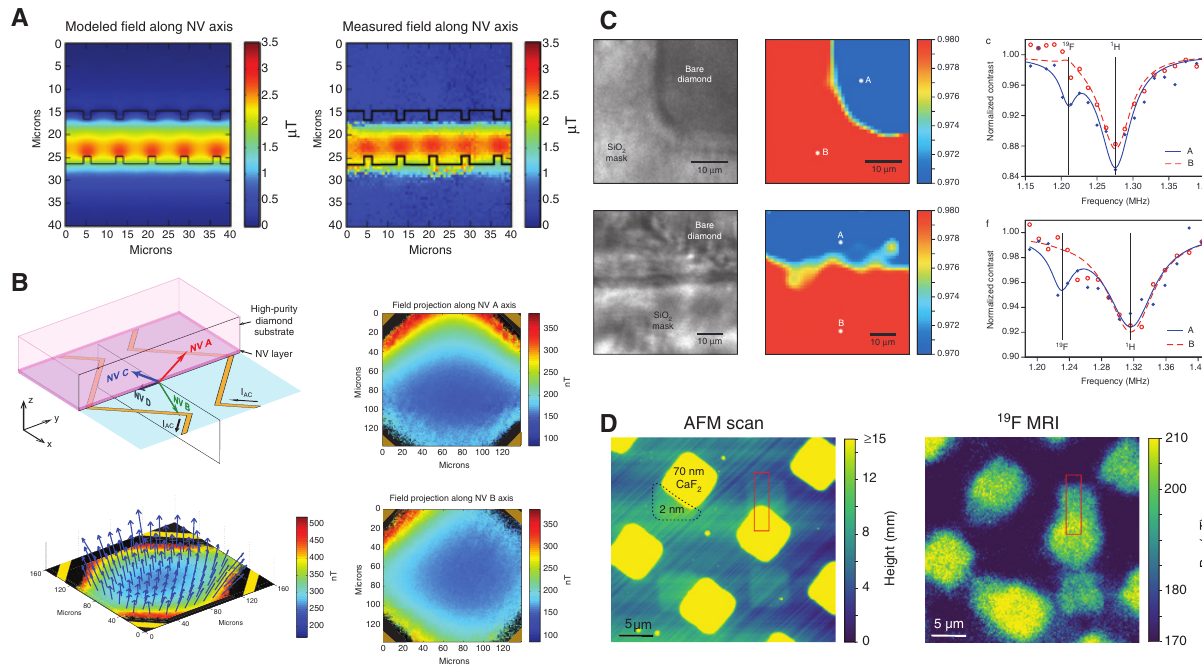
Figure 16: Examples of low-frequency QDM AC magnetic imaging. (A) Imaging magnetic field from current oscillating at 109.5 kHz [120]. (B) Imaging magnetic field from a wider field of view of current oscillating at 4.75 kHz [120]. (C) Imaging the presence of 19 F on diamond surface through NMR signal. (Reprinted with permission from Ref. [121]). (D) High spatial resolution imaging of patterned 19 F on diamond surface